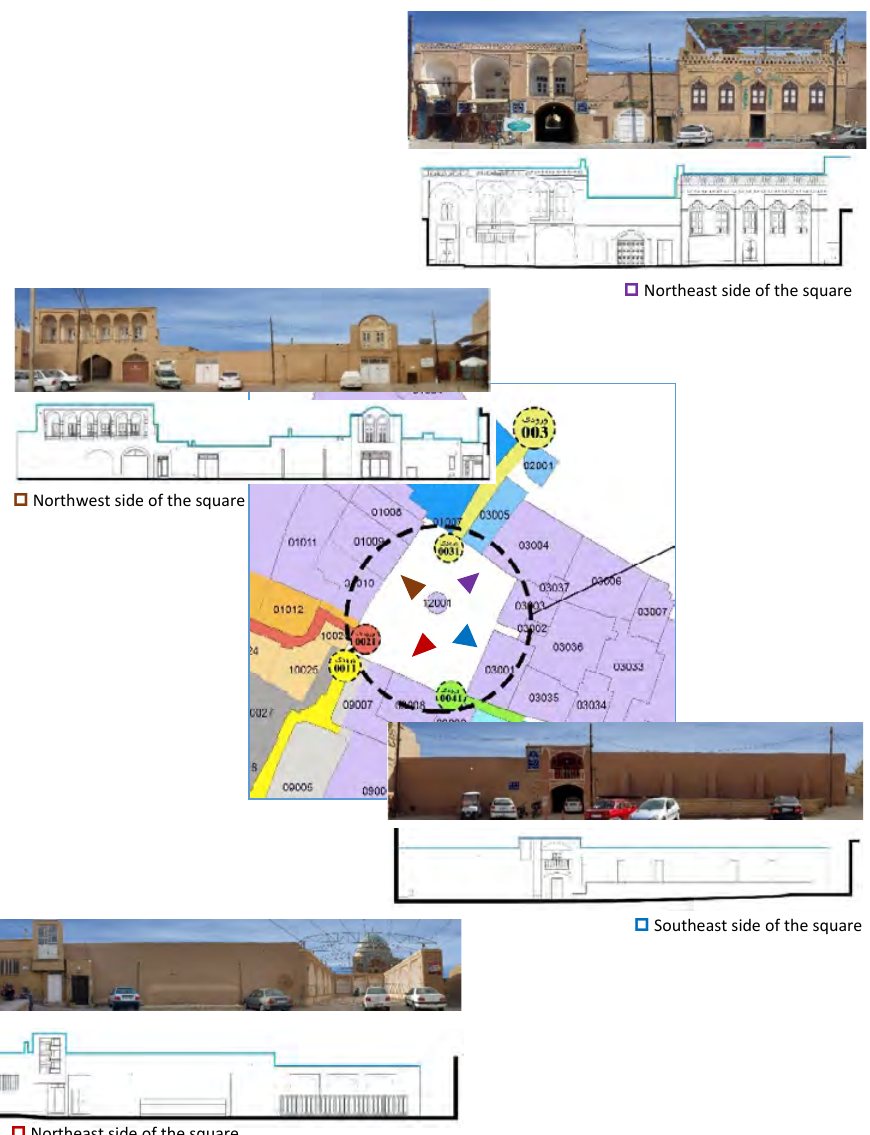
 Southeast side of the square